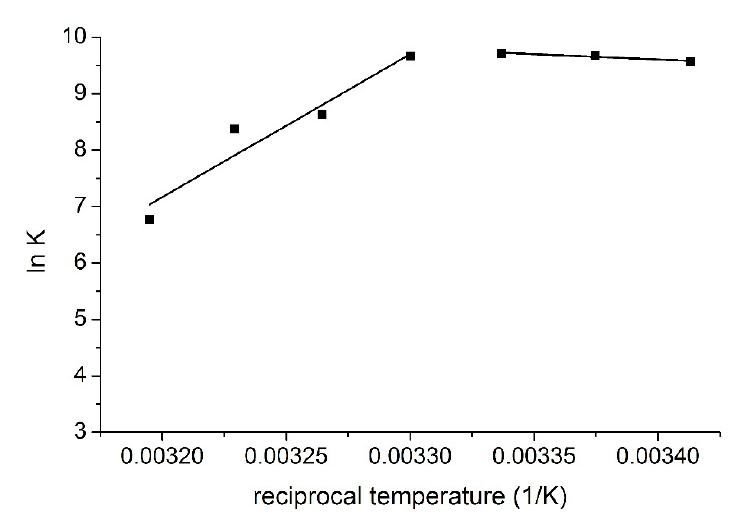
Figure 4. van ’t Hoff plot of the complex formation of MTX and TAC.